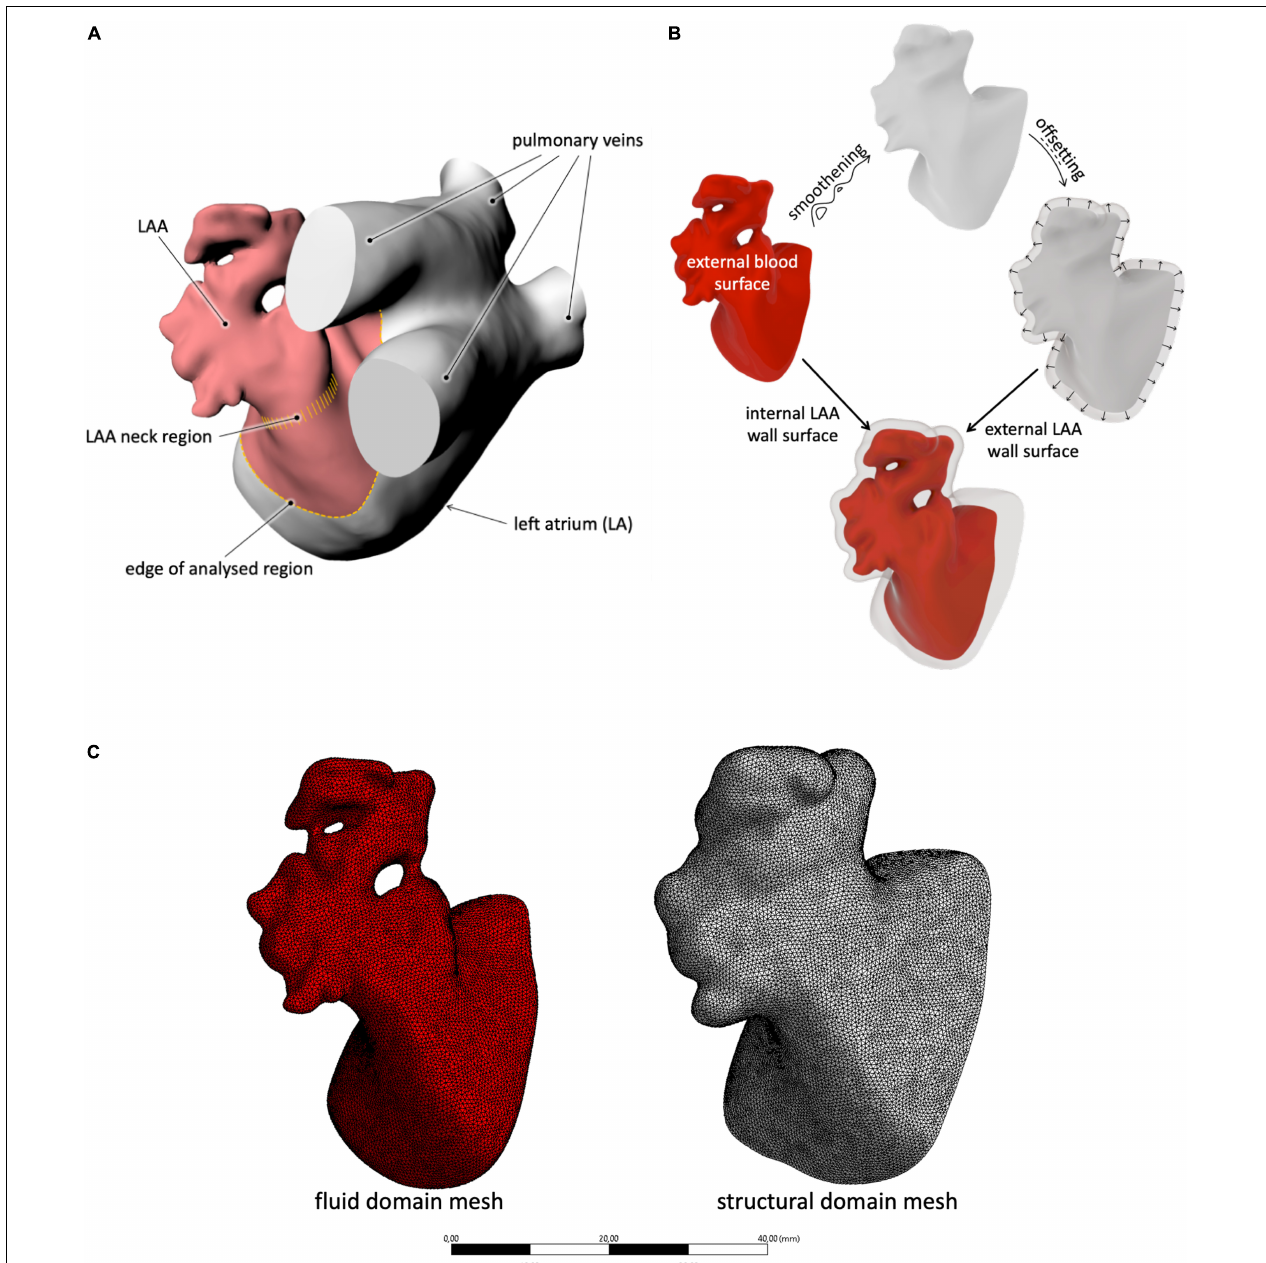
FIGURE 1 | (A) Description of the selection method adopted for the LAA study region; (B) schematic procedure used to generate the inner and outer LAA walls, starting from the external blood surface; and (C) example of mesh for both the solid and fluid domains with the selected size.